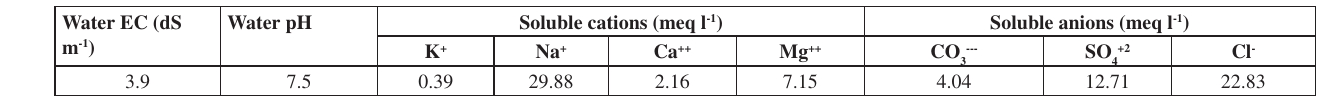
Table 3: Chemical analysis of irrigation water